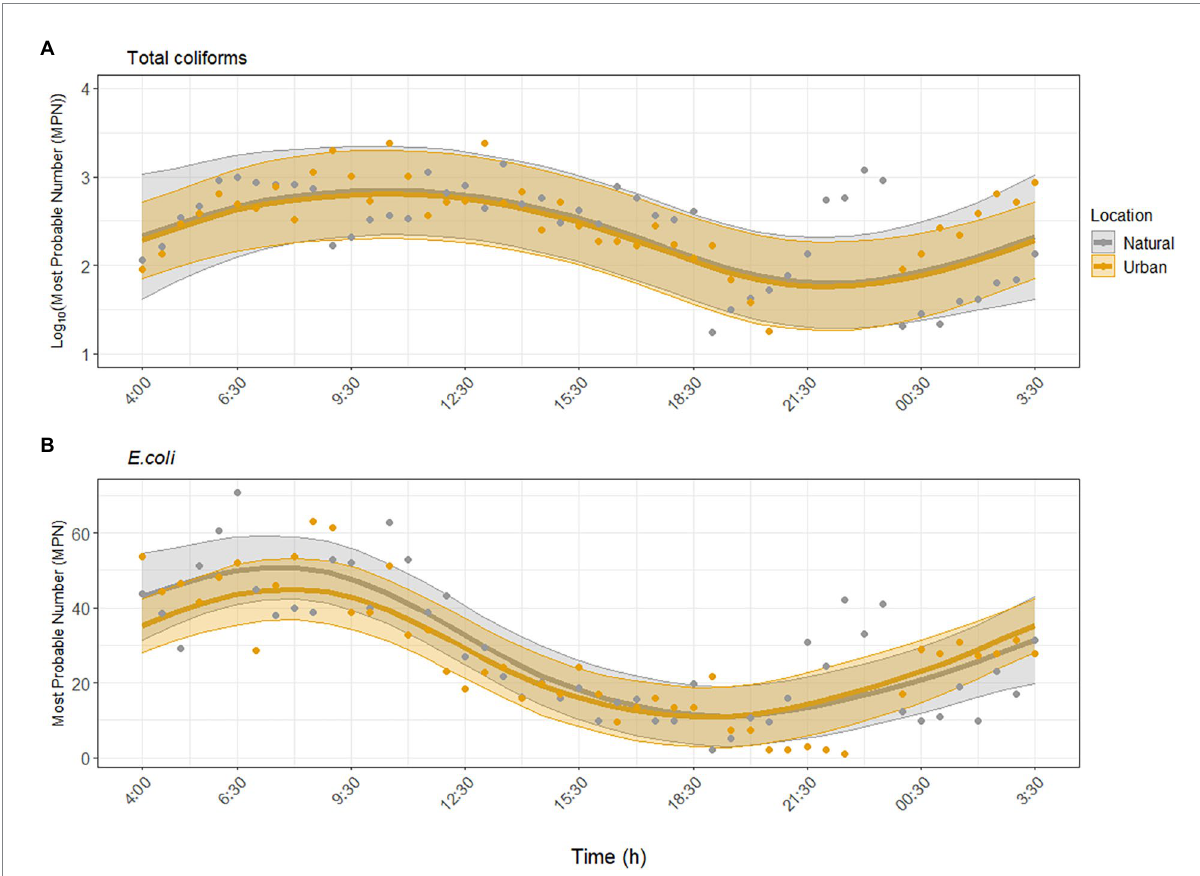
FIGURE 1 Dynamics of fecal indicator bacteria (A) total coliforms and (B) Escherichia coli over the sampling period at the urban (Paces Ferry) and natural (Cochran Shoals) sites independent of environmental factors. Solid lines represent model predictions with 95% confidence intervals. Points represent detected